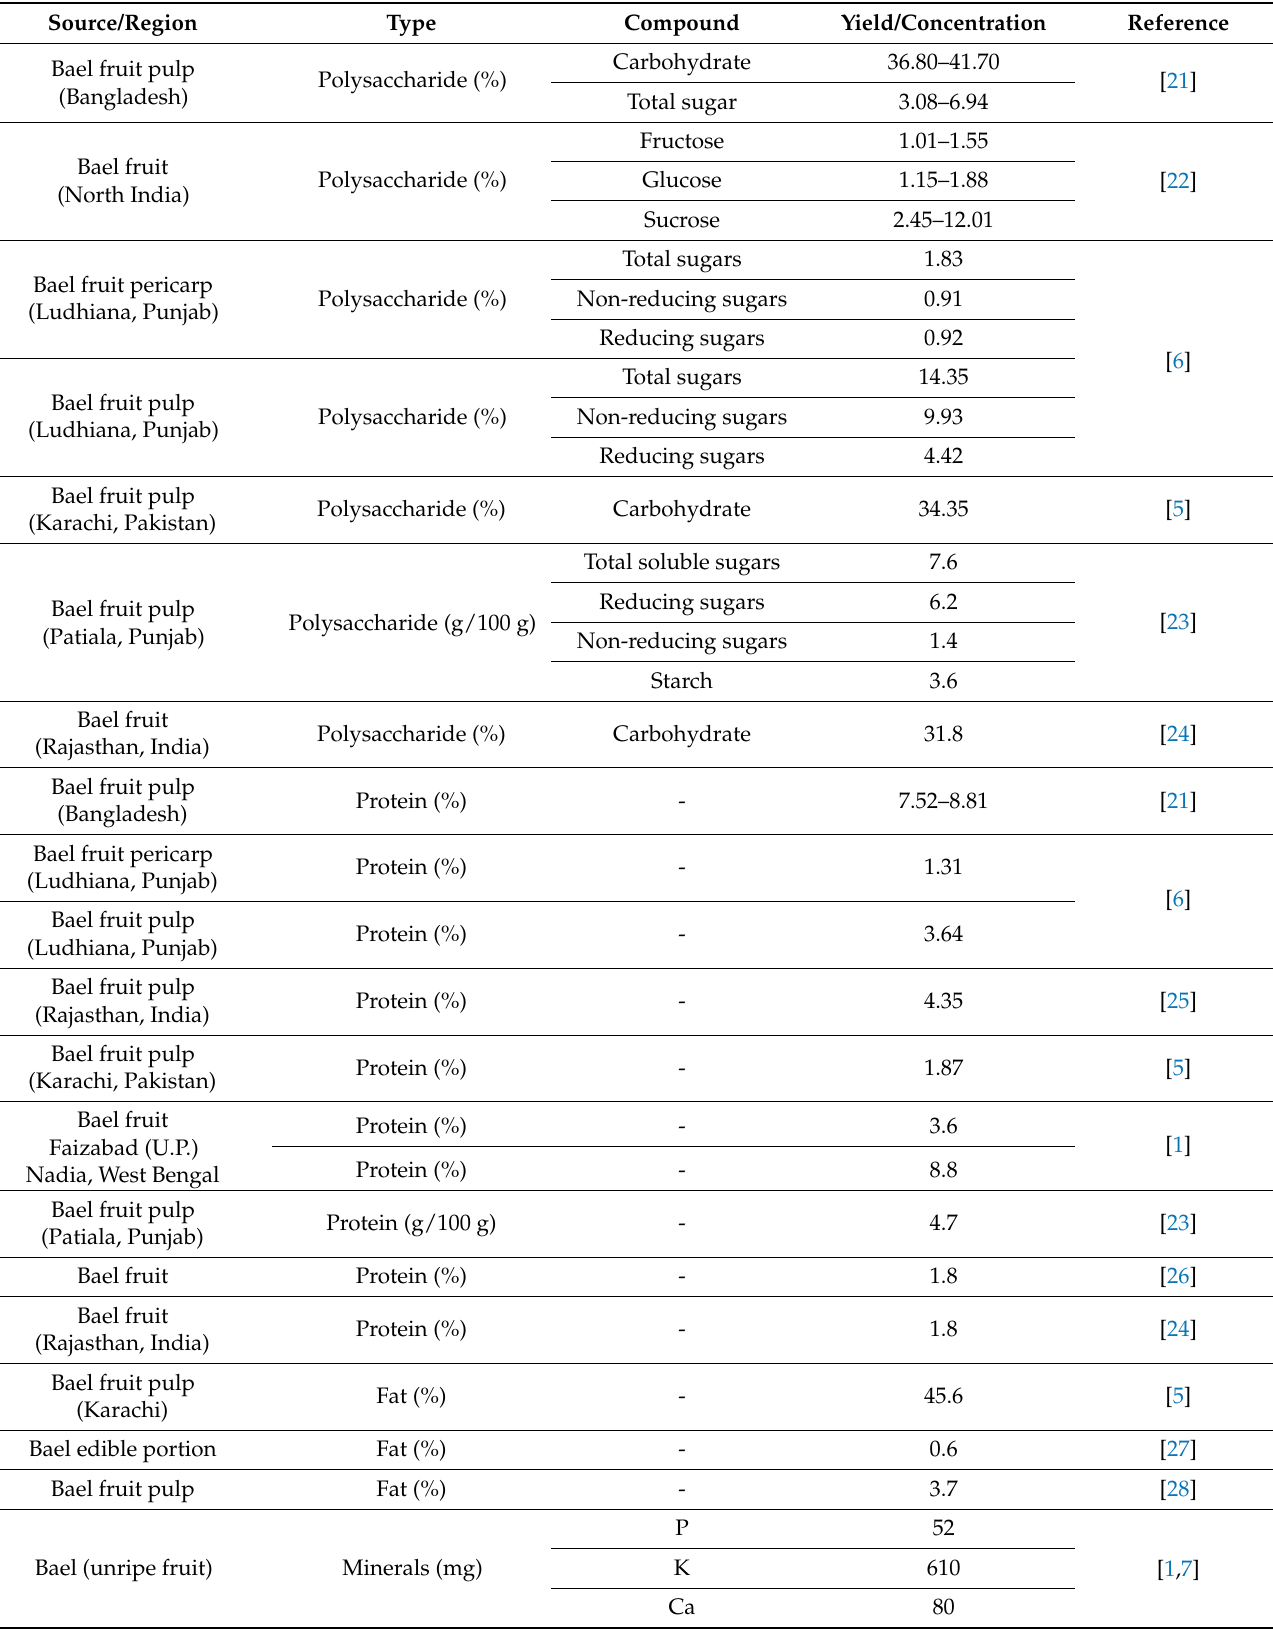
Table 1. Nutritional composition of bael ( Aegle marmelos (L.) Correa) fruit according to various